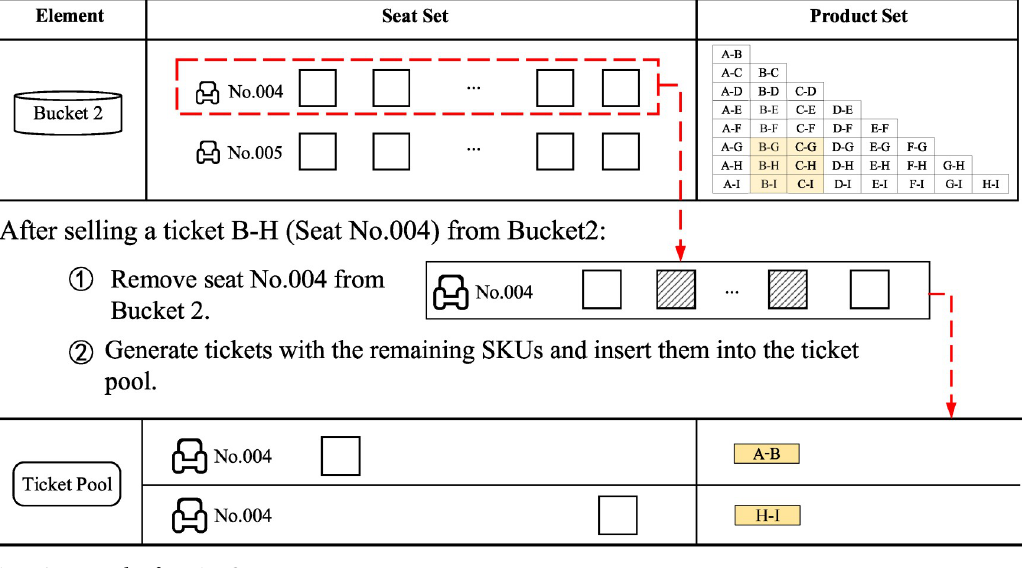
Fig 8. An example of reusing